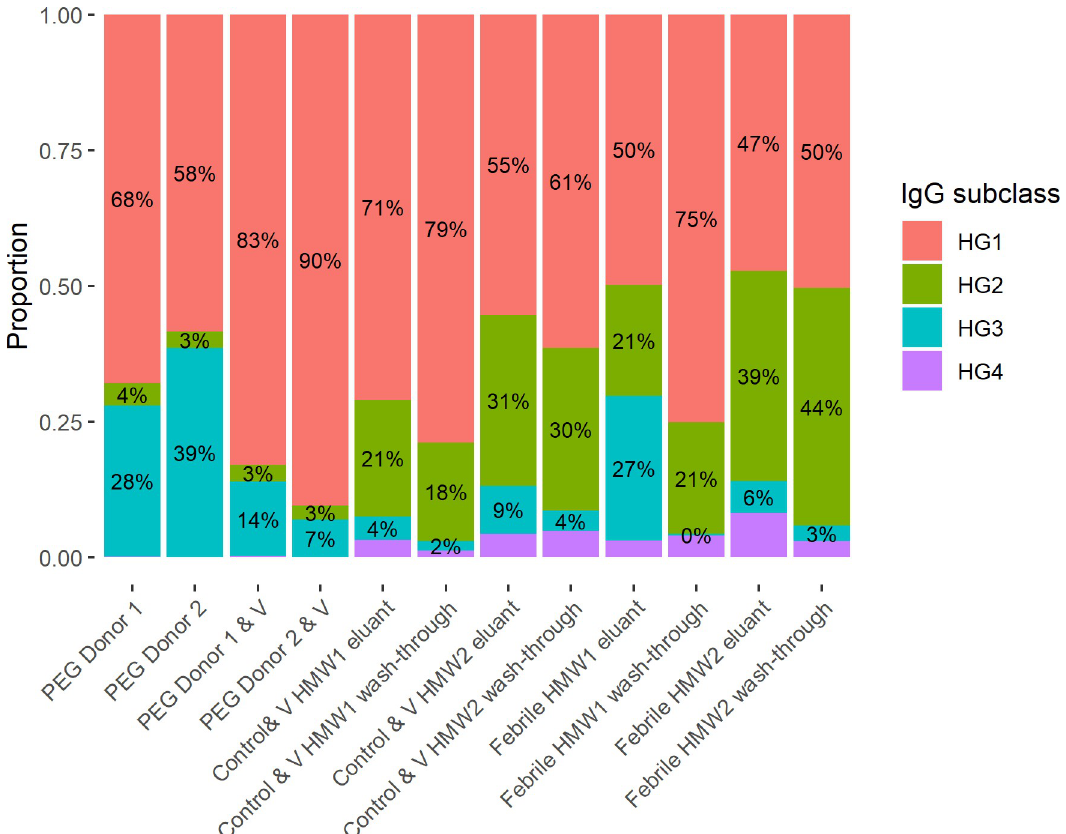
Fig 6. Proportion of estimated IgG mass by subclass (excluding contributions by non-specific peptides). PEG precipitated samples come from two donors (D1 and D2) and V indicates samples to which influenza vaccine was added. HMW1 refers to the highest molecular weight peak and HMW2 refers to the second peak. Febrile HMW1 eluant, wash-through and Febrile HMW2 eluant and wash-through are not spiked with vaccine. HG1: heavy chain of IgG subclass 1, HG2: heavy chain of IgG subclass 2, HG3: heavy chain of IgG subclass 3 and HG4: heavy chain of IgG subclass